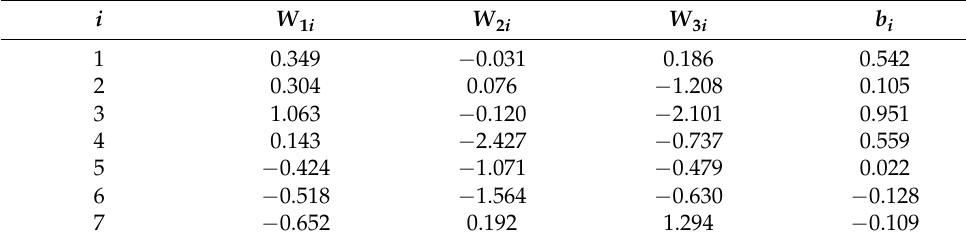
Table 6. Weight and bias values between input and hidden layer for LMANN.